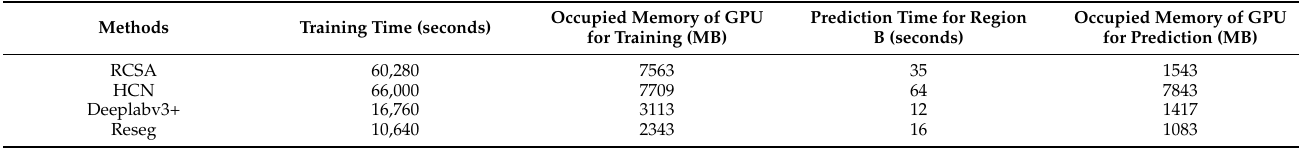
Table 7. Performance evaluation of different deep-learning based methods for semantic segmentation of aquaculture ponds in Part 2 of the experiments. Methods Training Time (seconds)